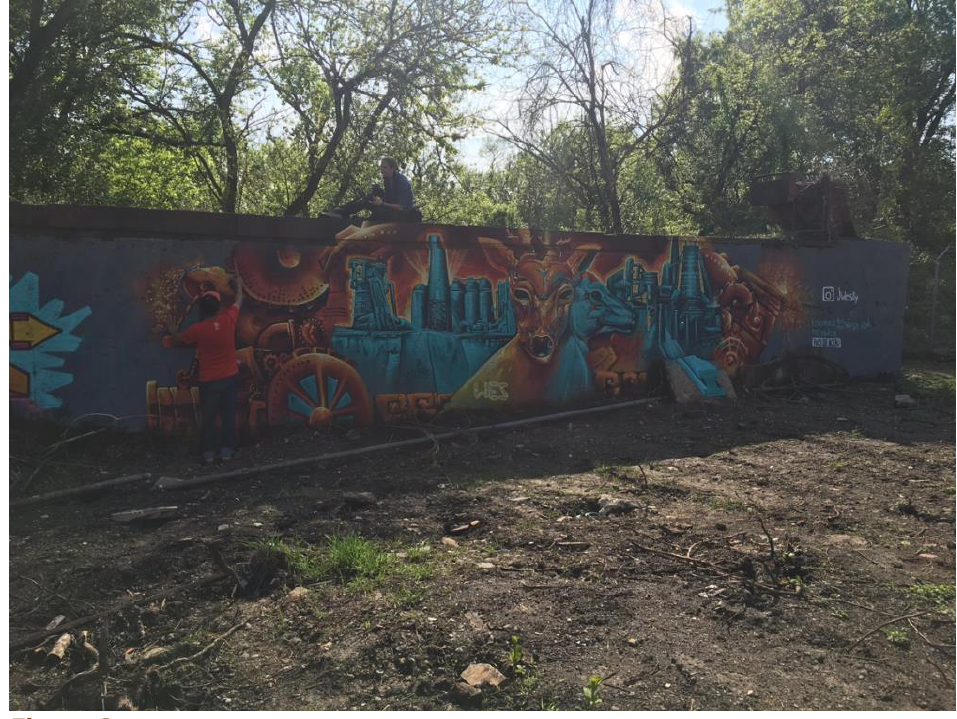
Caitlin Frances Bruce, The Wall Cry by Wes, Aerosol paint on wall, 2017, Rankin, Pennsylvania. Copyright: